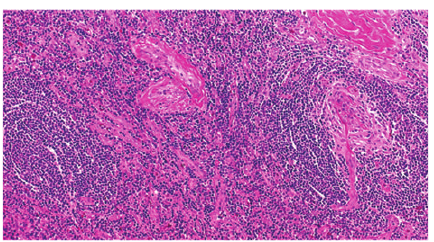
Figure 4: Histology shows the typical appearance of hyaline vascular type Castleman’s